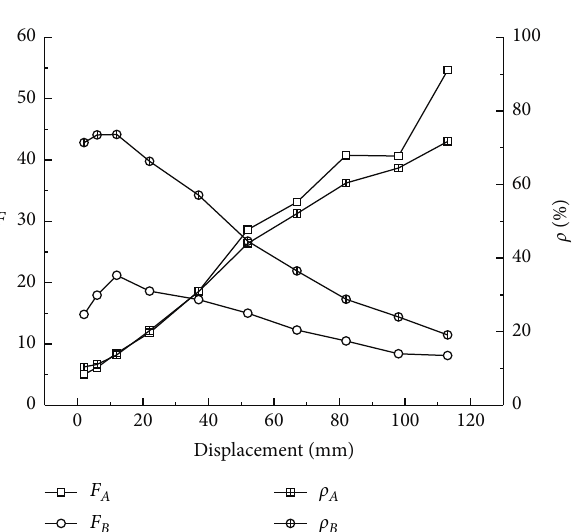
Figure 12: F distribution and contribution rate ρ displacement